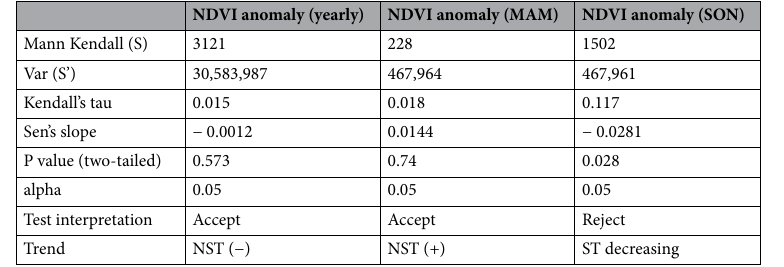
Table 9. M–K test of NDVI anomalies from 2002 to 2020 in the Borena zone.